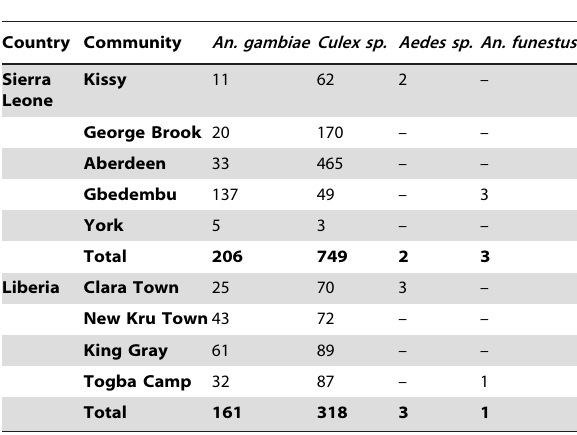
Table 1. Number of mosquito collections from each community in Freetown, Sierra Leone.